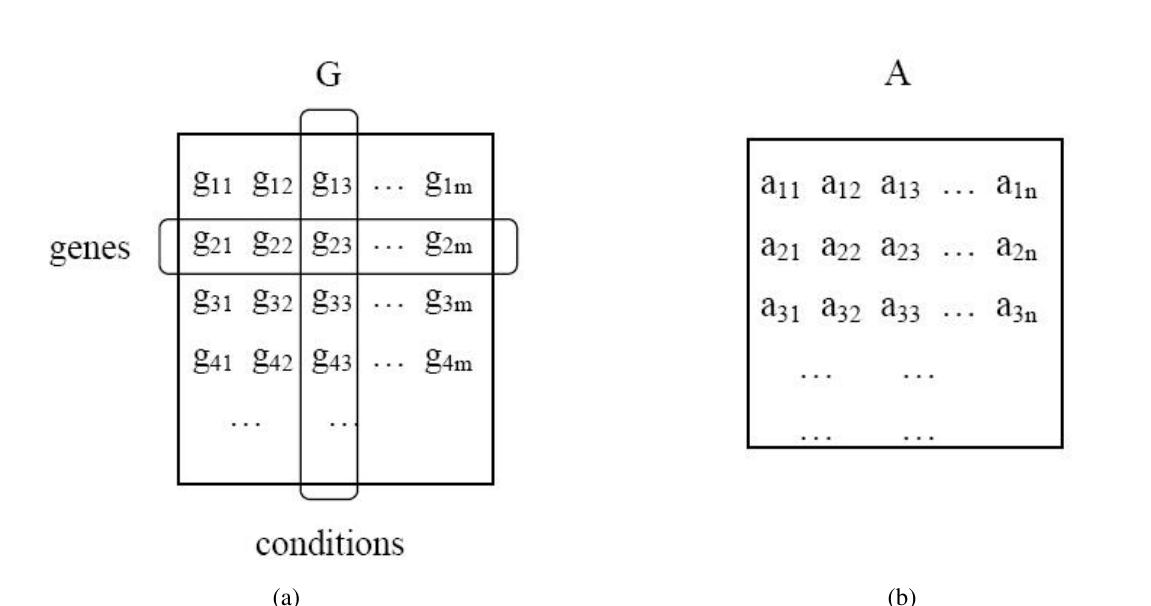
Figure 1: (a) Original gene expression profiles where each row stands for a gene and each column stands for a condition. (b) Similarity matrix for the